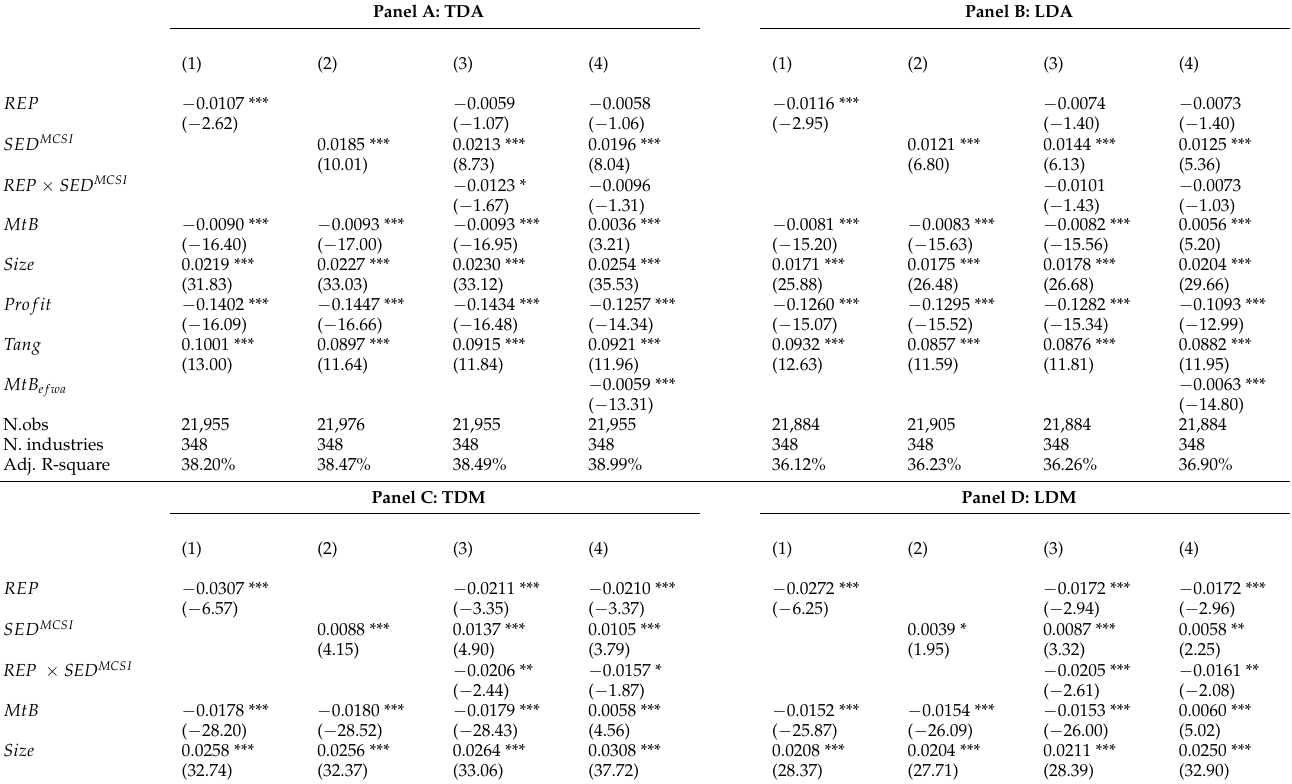
Table 3. Consumer Sentiment, Republican Managers, and Financial